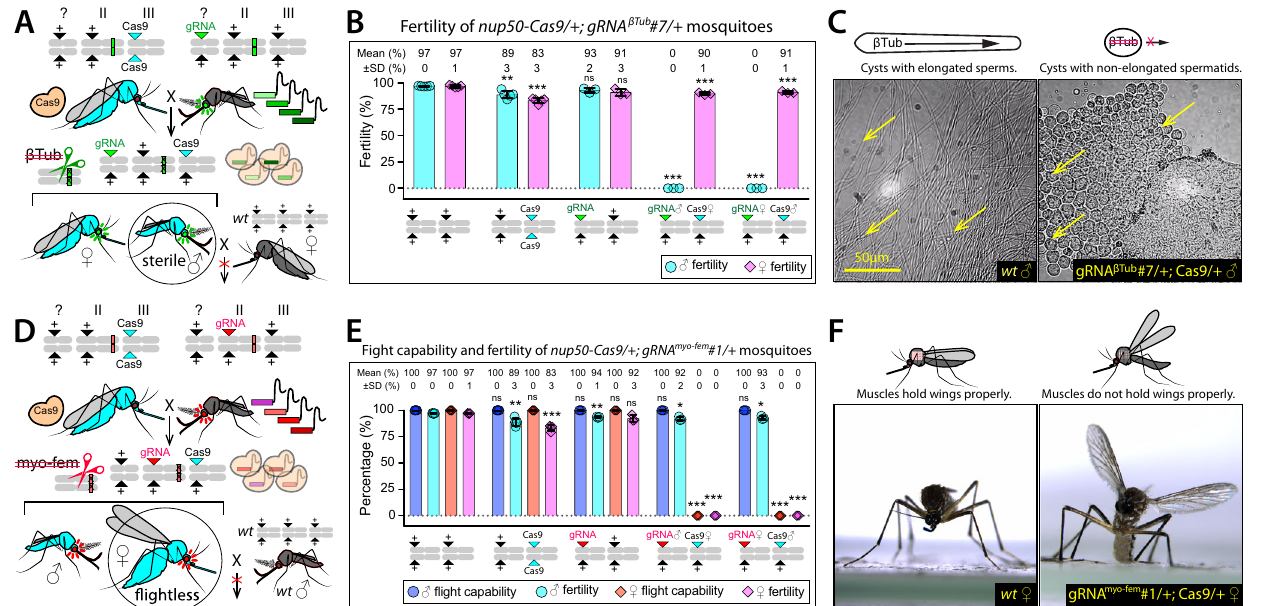
Fig. 1 Validation of pgSIT target genes. Cas9/gRNA-mediated disruption of β Tub or myo-fem results in ( A – C ) male ( ♂ ) sterility or ( D , E ) female ( ♀ ) fl ightlessness, respectively. Schematics of genetic crosses to assess the ef fi ciency of ( A ) β Tub or ( D ) myo-fem disruption in the F 1 transheterozygous progeny. B Bar graph indicating the percent of fertile progeny for each of the various progeny genotypes using gRNA β Tub #7 line. C Imaging of seminal fl uid from wildtype (WT) and gRNA β Tub #7/ + ;Cas9/ + mosquitoes, showing the difference in spermatid elongation caused by the disruption of β Tub (Supplementary Video 1). Nonelongated spermatid phenotype was observed in each examined F 1 transheterozygous ♂ . E Bar graph showing percent of fertile and fl ight-capable mosquitoes in each cross using gRNA myo-fem #1 line (Supplementary Videos 1 – 3). F Imaging showing the speci fi c wing posture phenotype induced by the myo-fem disruption in ♀ ’ s, but not in ♂ ’ s, in which the resting wings were uplifted. Data from both paternal Cas9 crosses (Cas9 ♂ × gRNA ♀ ) and maternal Cas9 crosses (Cas9 ♀ × gRNA ♂ ) are shown (Supplementary Fig. 2, Supplementary Fig. 3, and Supplementary Table 3). Bar plots show means ± one standard deviation (SD) over at least three ( n ≥ 3) biologically independent F 1 progeny groups, and mean and SD values rounded to a whole number. A two-sided F test was used to assess the variance equality. Statistical signi fi cance of mean differences was estimated using a